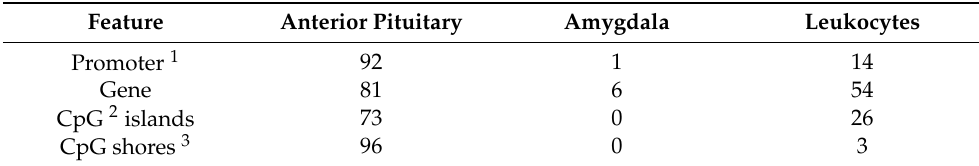
Table 4. The numbers of genomic features that had significant variation in DNA methylation in both the Prenatally Stressed and Control